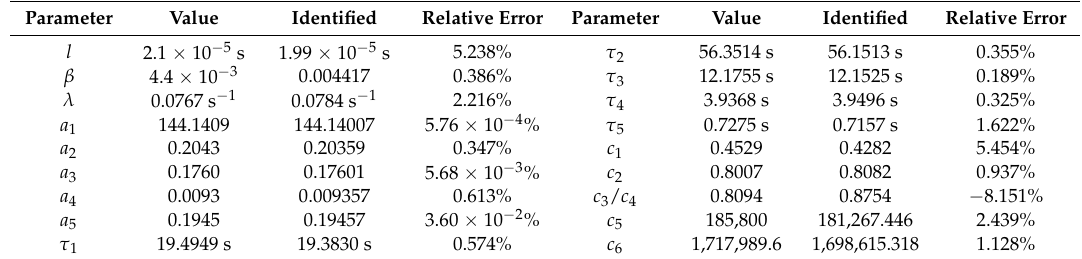
Table 2. Model parameter values.